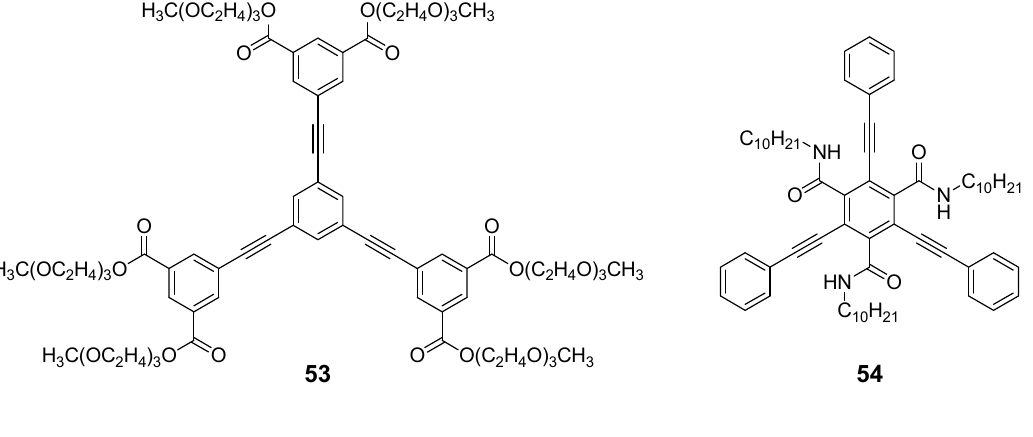
Figure 14. Star-shaped mesogens with a rigid 1,3,5-tris(phenylethenyl) benzene